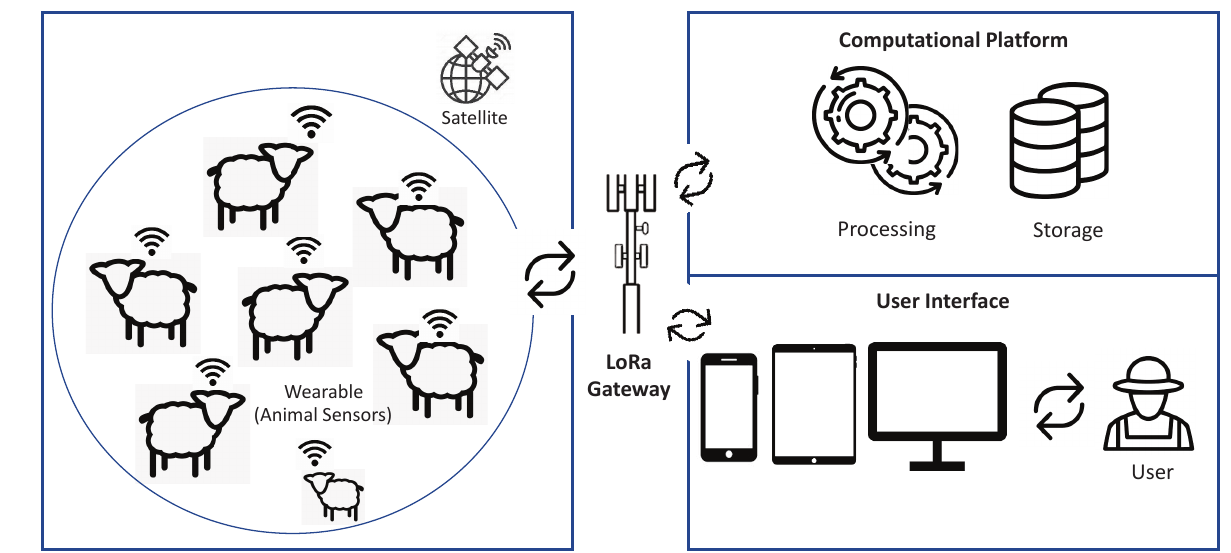
Figure 2. System